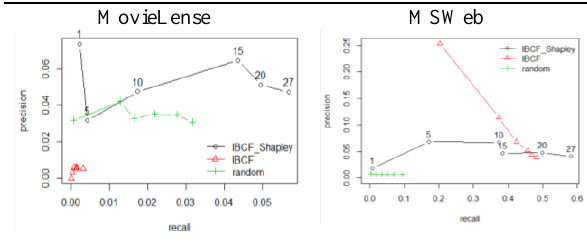
Figure 7. Recision/Recall of three